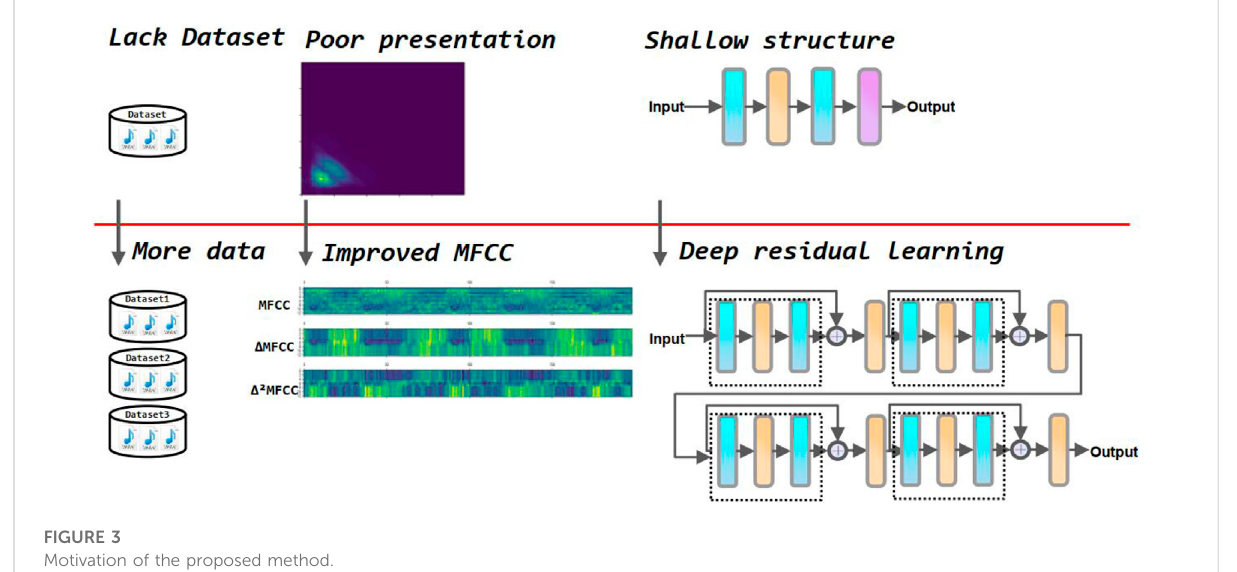
FIGURE 3 Motivation of the proposed